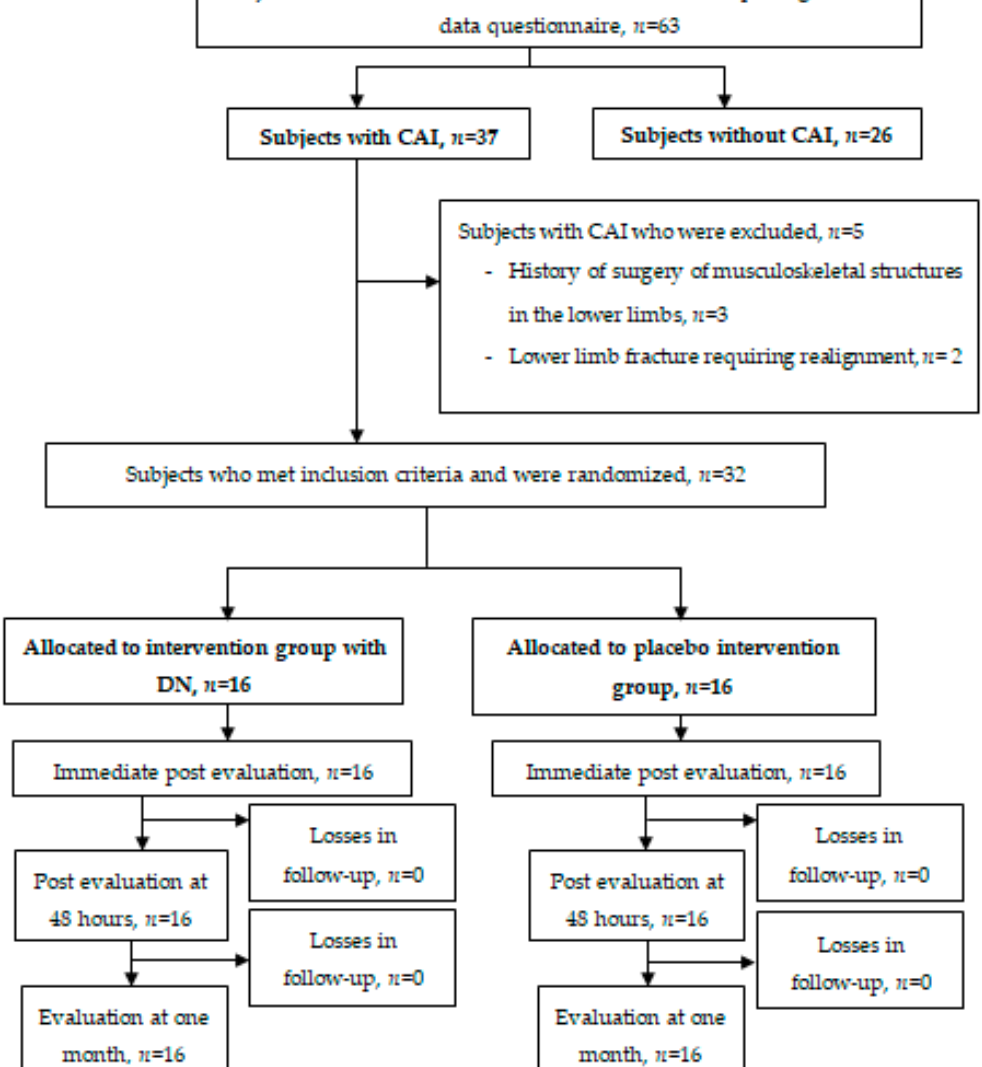
Figure 4. Flowchart of participants. AII = Ankle Instability Instrument, CAIT = Cumberland Ankle Instability Tool, CAI = Chronic Ankle Instability, DN = Dry Needling.